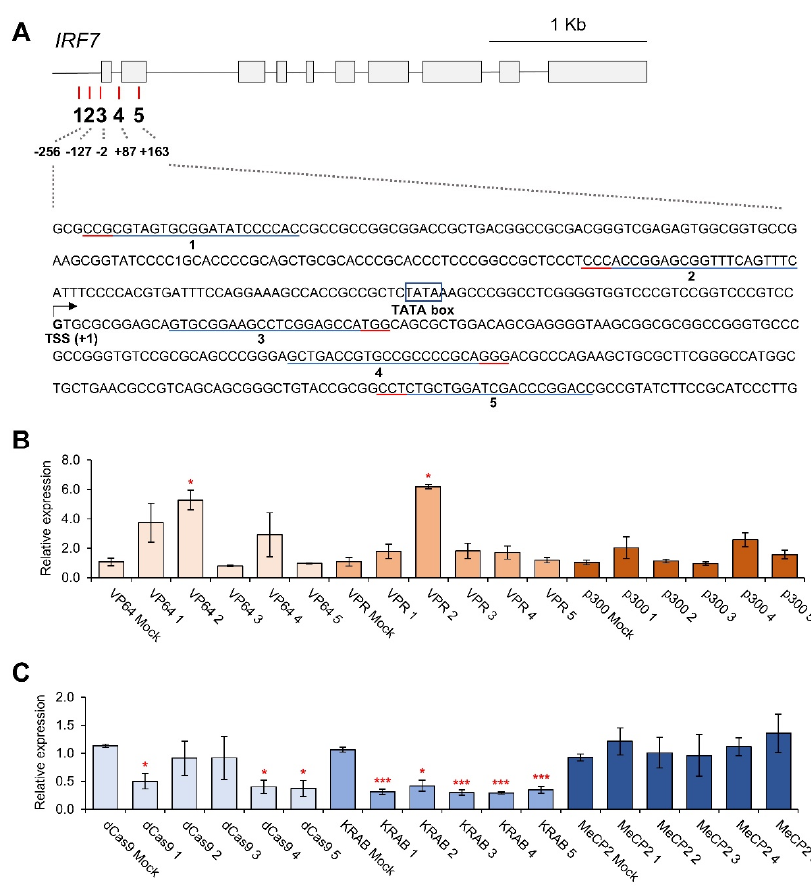
Figure 4. The regulation of the chicken IRF7 gene expression by individual gRNAs in CRISPRa and CRISPRi DF-1 cells. ( A ) Gene structure of IRF7 gene and the location of gRNAs (1, 2, 3, 4 and 5). The number indicates the position of gRNAs. Grey rectangles indicate exons. Scale bars, 1 Kb. TATA box and transcription start site (TSS) are marked. The blue bar indicates the gRNA binding site, and the red bar indicates the protospacer adjacent motif sequence (PAM). Quantitative analysis in the indi- vidual gRNA-treated CRISPRa DF-1 cell lines ( B ), and CRISPRi DF-1 cell lines ( C ). Data are shown as the mean ± SEM. Signi fi cant di ff erences between the mock controls and gRNAs-transfected sam- ples were determined by Student’s t -test. Statistical signi fi cance was ranked as * p < 0.05, *** p < 0.001.